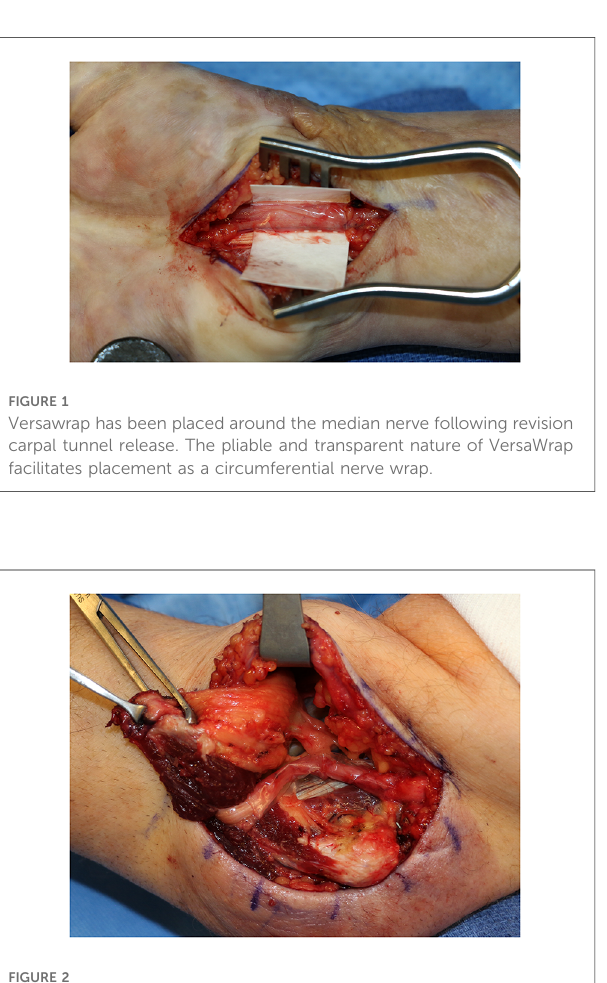
FIGURE 2 Versawrap has been placed around the ulnar nerve following revision cubital tunnel release, in preparation for submuscular transposition. The pliable and transparent nature of VersaWrap facilitates placement as a circumferential nerve